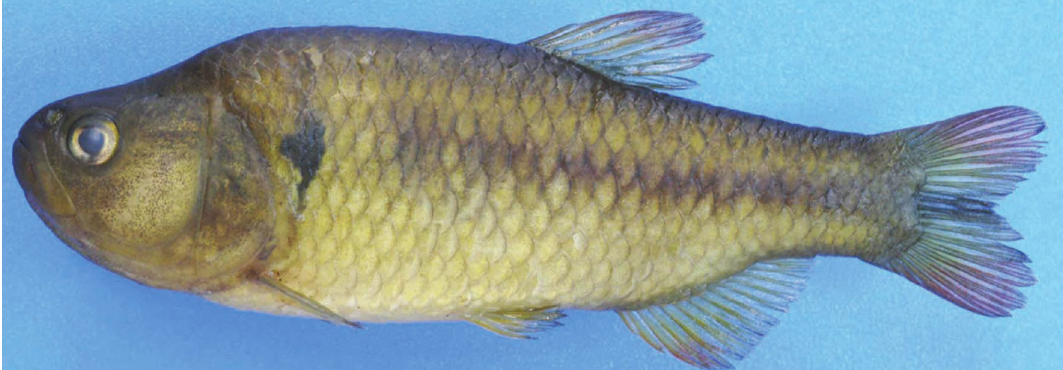
Fig. 2. Hasemania uberaba , paratype, recently fixed specimen, DZSJRP 8730, female, 62.4 mm SL, Brazil, Minas Gerais State, Ponte Alta, Serra do Grotão, road BR 262, headwaters of rio Uberaba, córrego São Pedro, rio Grande basin, upper rio Paraná